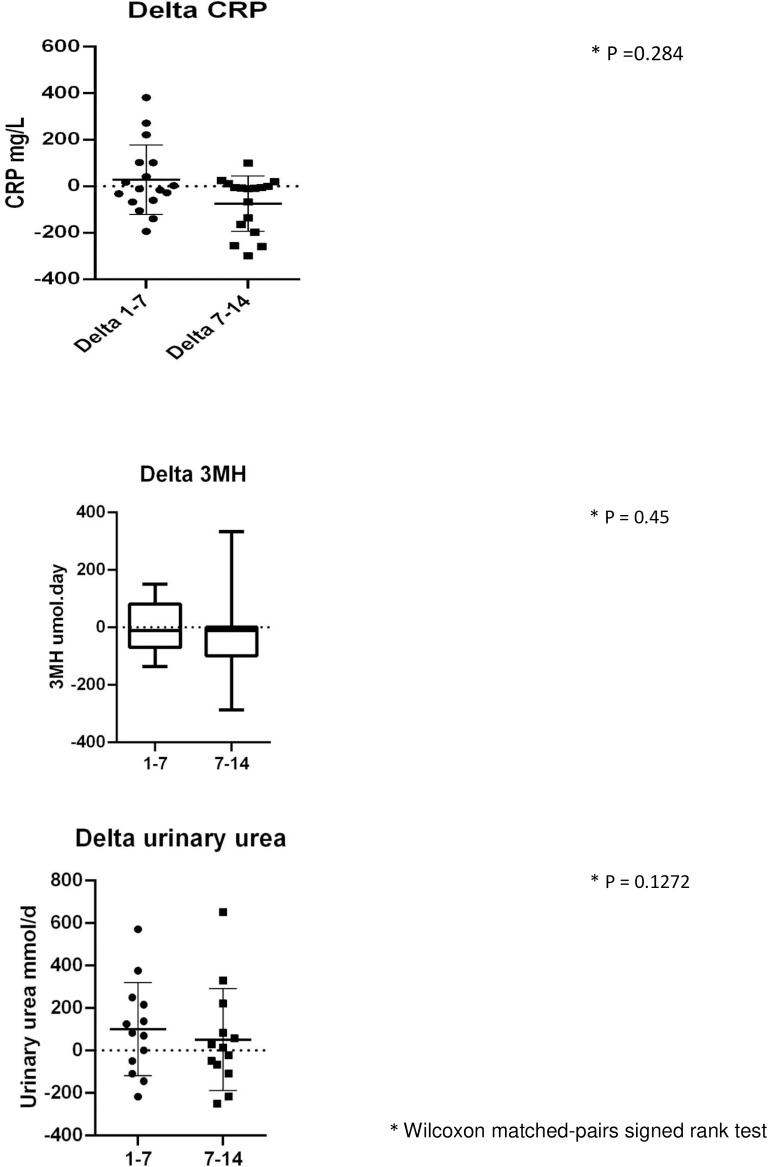
Data comparing the first versus the second week of study: Urinary urea (N = 14), 3-MH (N = 14), CRP (N = 17) and muscle loss (N = 17).